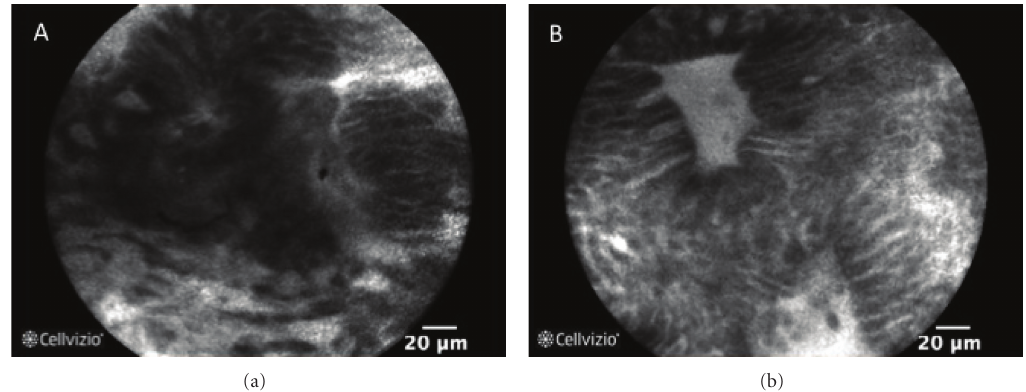
Figure 2: p-CLE fluorescein sodium 10% imaging examples of crypt types of patients in active ulcerative colitis. (a) crypt fusion and distortion; (b) dilation of crypt openings, with fluorescein leaks into the crypt lumen therefore making the lumen brighter than the surrounding epithelium.